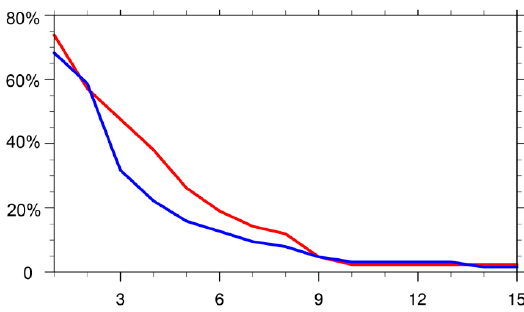
Figure 3. The probability of average PDI (10 5 m 3 /s 3 ) occurrence exceeding a certain threshold in EPW years (red line) and CPW years (blue line). The abscissa was threshold of PDI, and the ordinate was probability of PDI occurrence. Atmosphere 2019 , 10 , x FOR PEER REVIEW